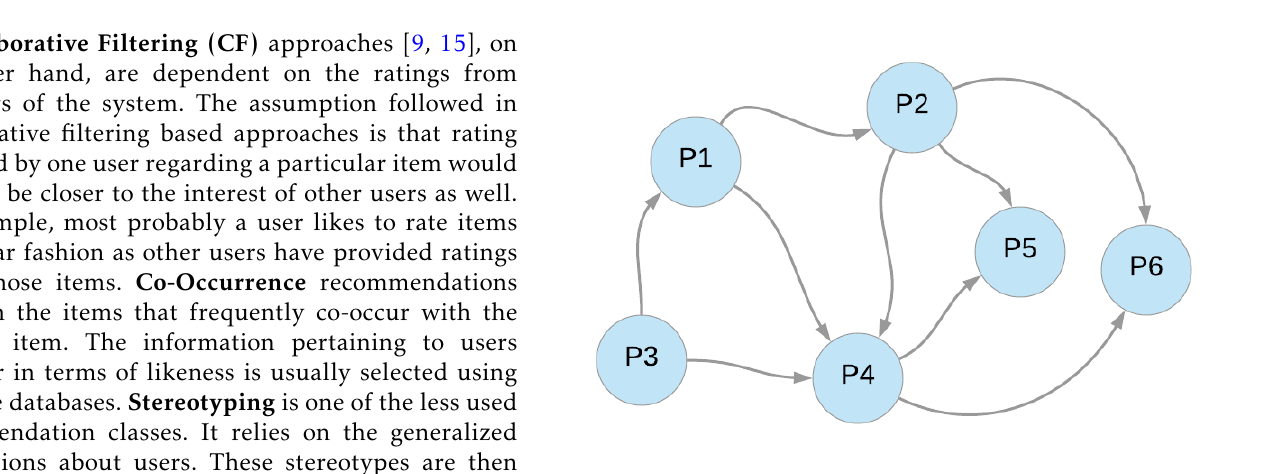
Figure 2. Citation